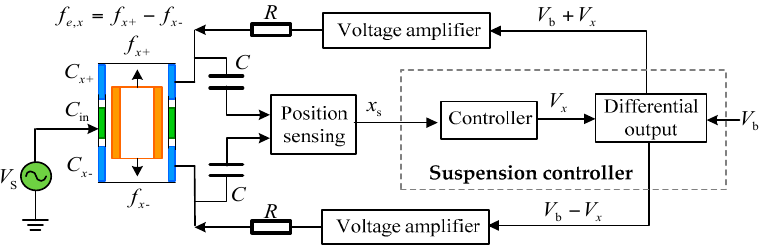
Figure 5. Schematic sketch of the x -axis electrostatic suspension loop. Five loops similar to this one are required to suspend each test mass electrostatically.